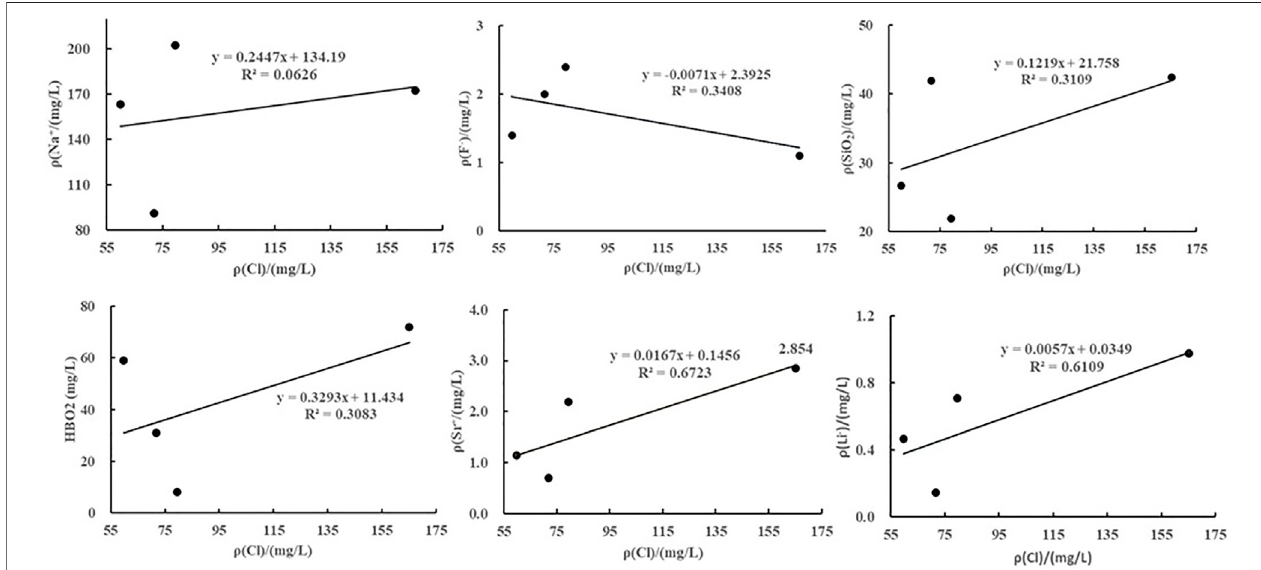
FIGURE 4 | Curves showing the relationships between the ions and Cl − in the warm springs in the Jiangcang Basin.